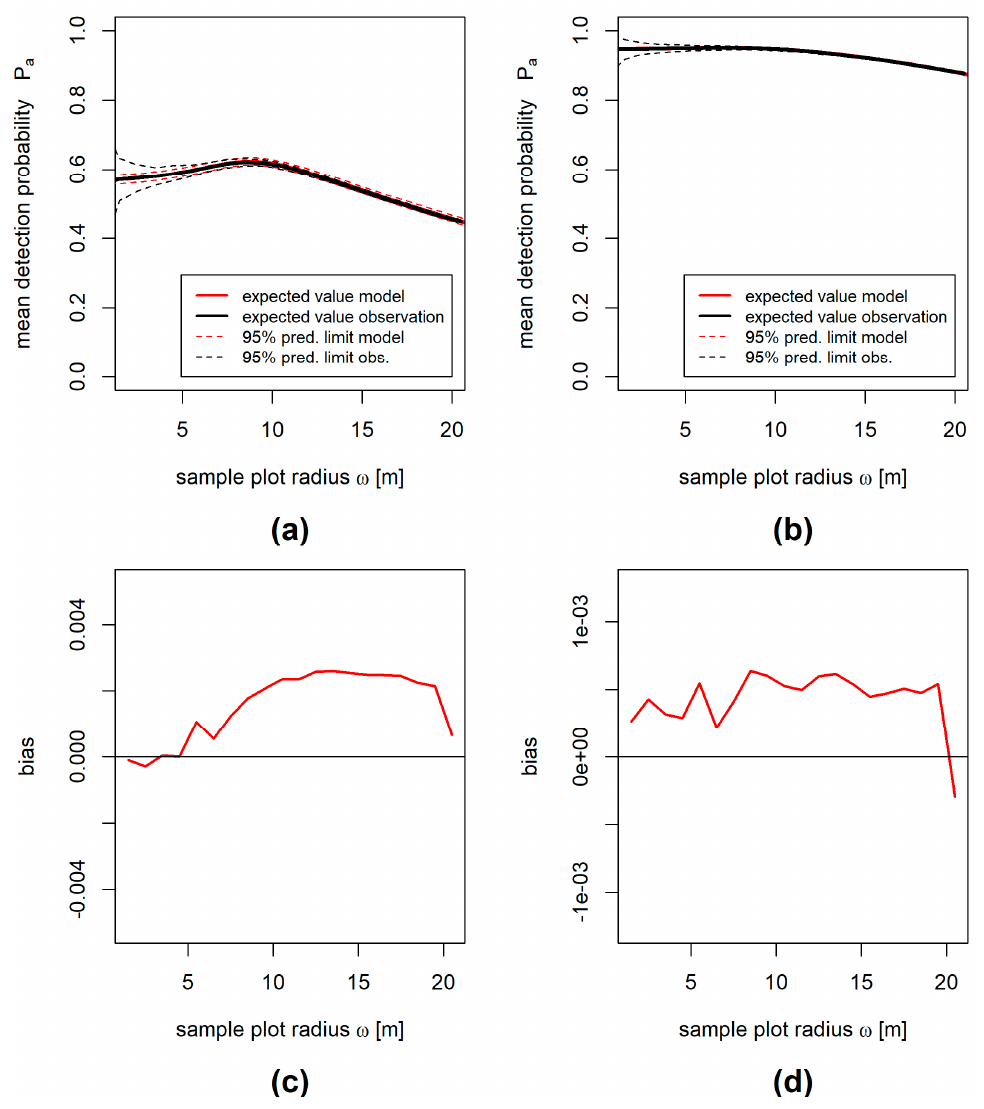
Figure 9. Results of the simulation study (200 simulation runs of 250 sample plots) for both strata, using annuli of 0.1 m widths for model fitting to the simulated multi-scan data. ( a , b ) Mean detection probability P a for di ff erent sample plot radii ω using simulated TLS in multi-scan mode. The solid black line represents the expectation of the simulated data; the solid red line represents the expectation of the model prediction. The dashed lines represent the corresponding 95% prediction limits, i.e., the 2.5% and 97.5% quantiles of the 200 simulation runs. ( c , d ) Model bias dependent on the sample plot radius. ( a , c ) Small trees (5 cm ≤ dbh < 20 cm) and ( b , d ) large trees (dbh ≥ 20 cm).